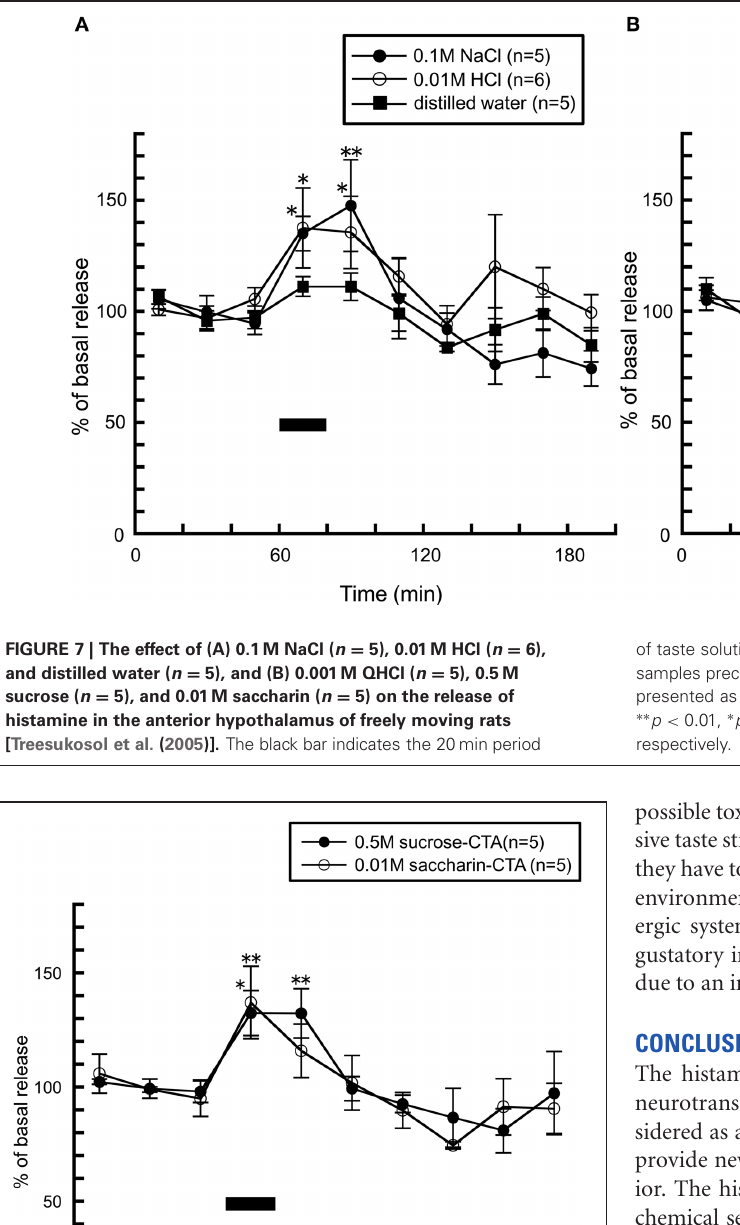
FIGURE 8 | The effects of 0.5M sucrose ( n = 5) and 0.01M saccharin ( n = 5) to conditioned (CTA) rats on the release of histamine in the anterior hypothalamus [Treesukosol et al. (2005)]. The black bar indicates the 20min period of taste solution infusion. The mean values of the three baseline samples preceding intraoral infusion were taken as 100%. Values are presented as percentages of the mean basal release ± SEM ∗∗ p < 0 . 01, ∗ p < 0 . 05 compared with the basal release of each group,